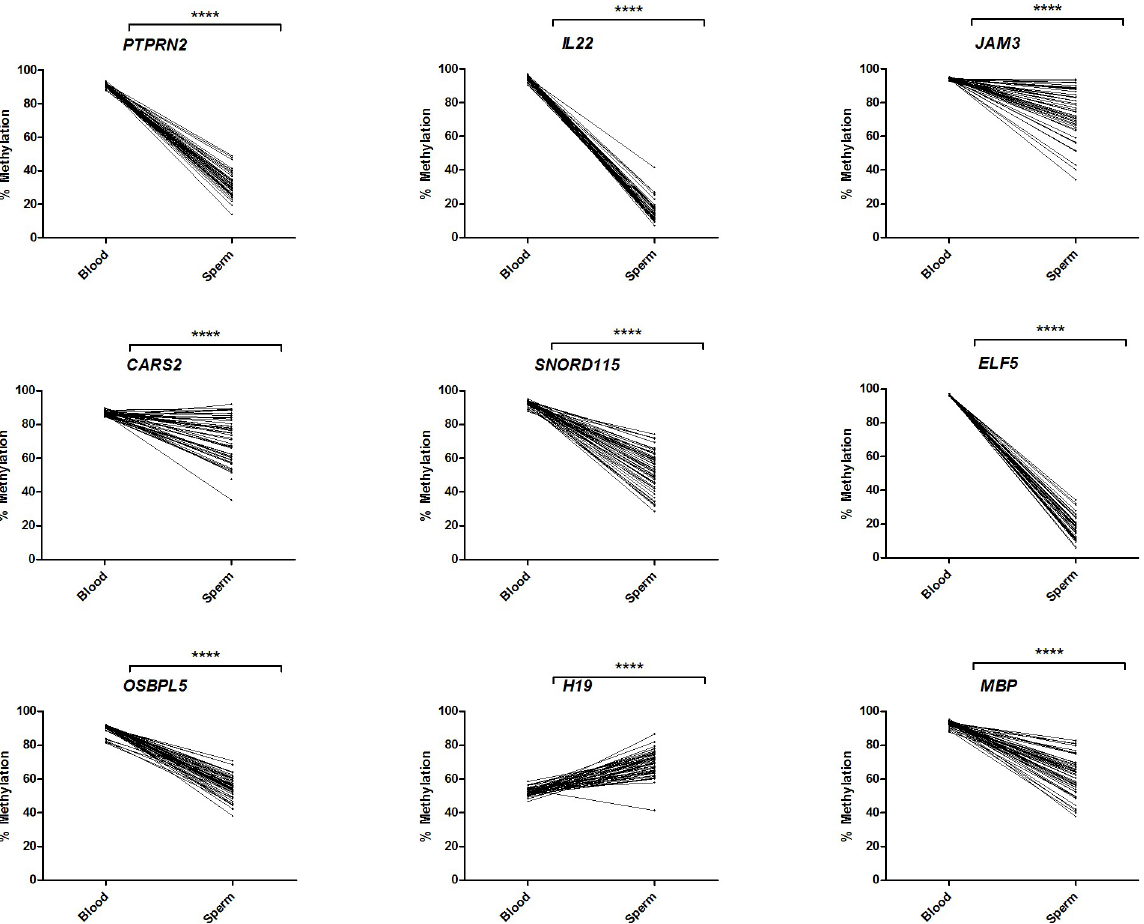
Fig 3. Comparison of methylation levels in blood and sperm samples. Methylation was measured in paired blood samples collected from the same individuals who provided semen samples by pyrosequencing. Differences between tissues were analyzed by paired t-test. ���� , p < 0.0001.